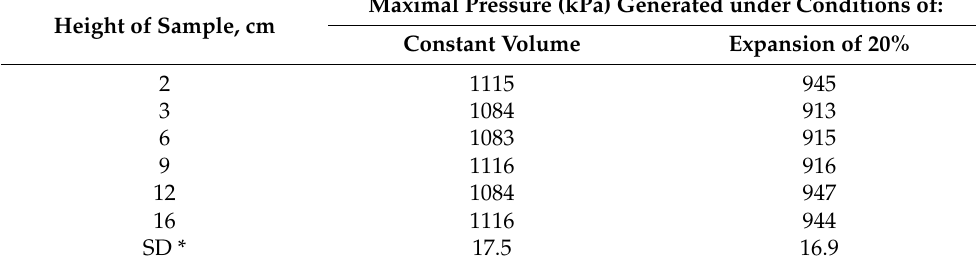
Table 3. Values of the maximal pressure generated by the samples of the examined blend of vari- ous